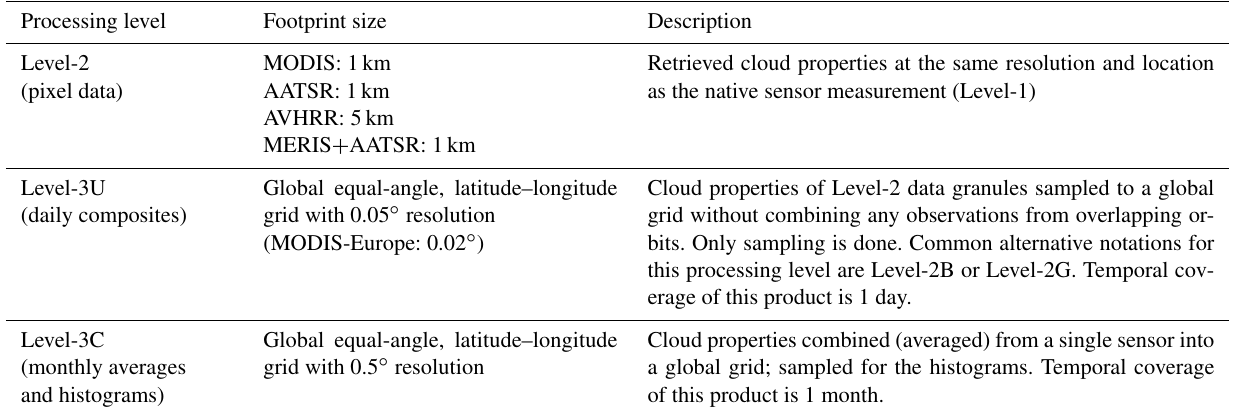
Table 3. Processing levels of Cloud_cci data products. The footprint refers to the area on the Earth’s surface that is covered by one sensor pixel at nadir